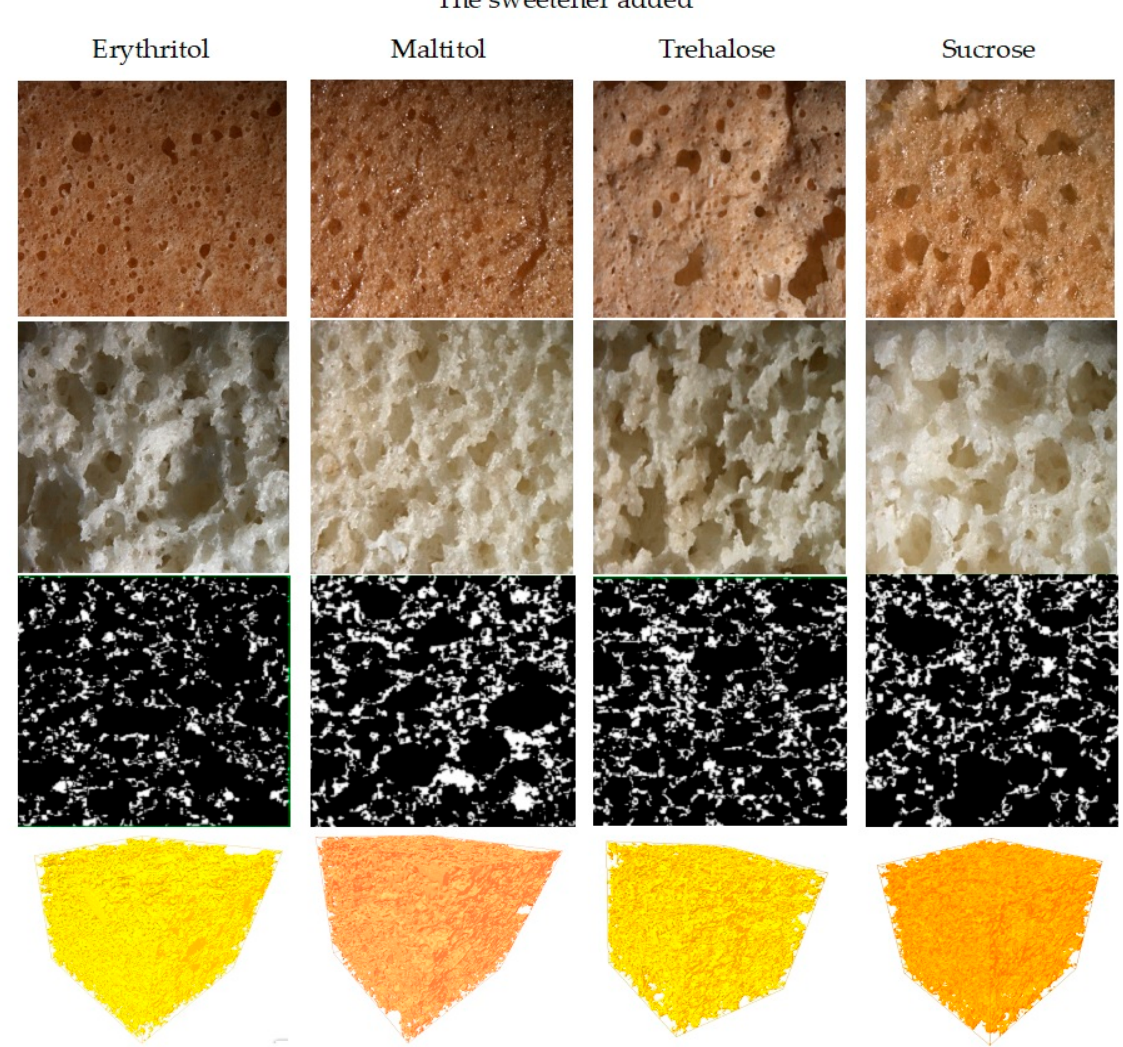
Figure 2. Images and characteristics of the porous structure of sponge cakes with sweetener.